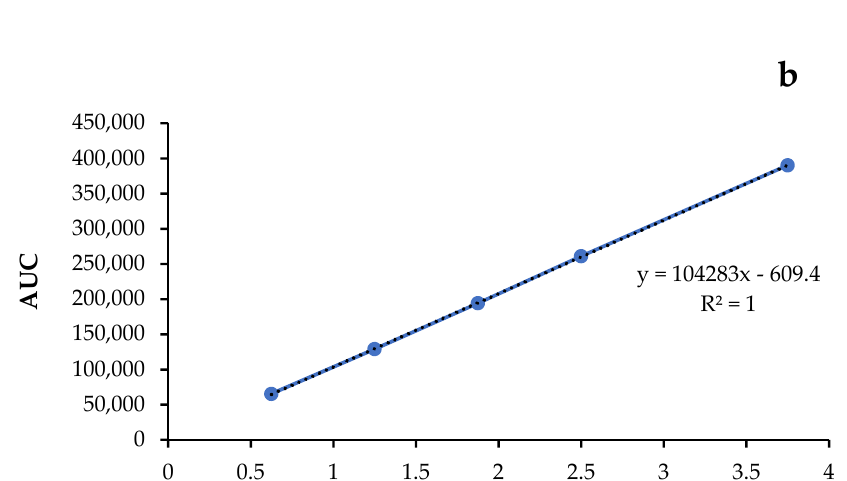
Table 3. Theoretical spiked concentration, the average actual determined concentration, and the percent recovery of salmeterol xinafoate and fluticasone propionate.